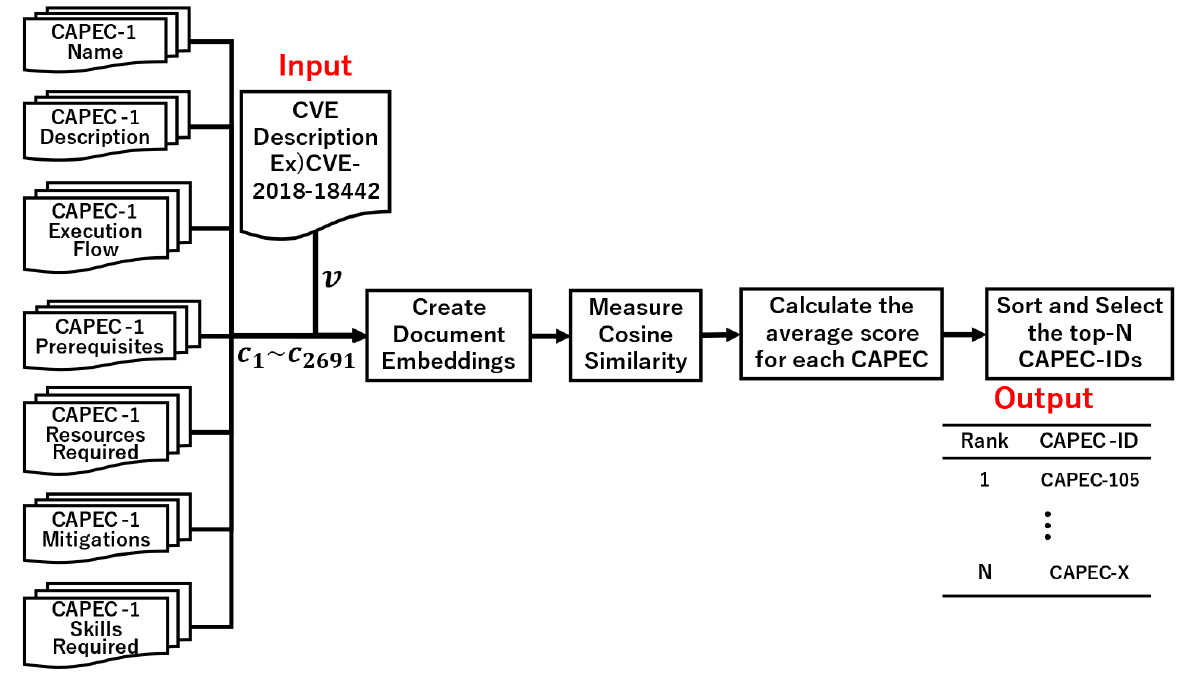
Figure 3. Overview of the proposed approach using the section average.